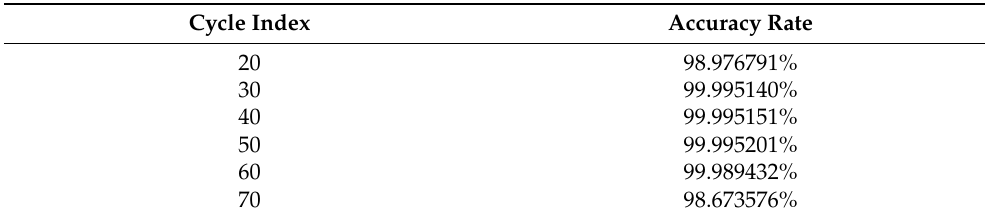
Table 3. Relationship between the cycle index and accuracy.